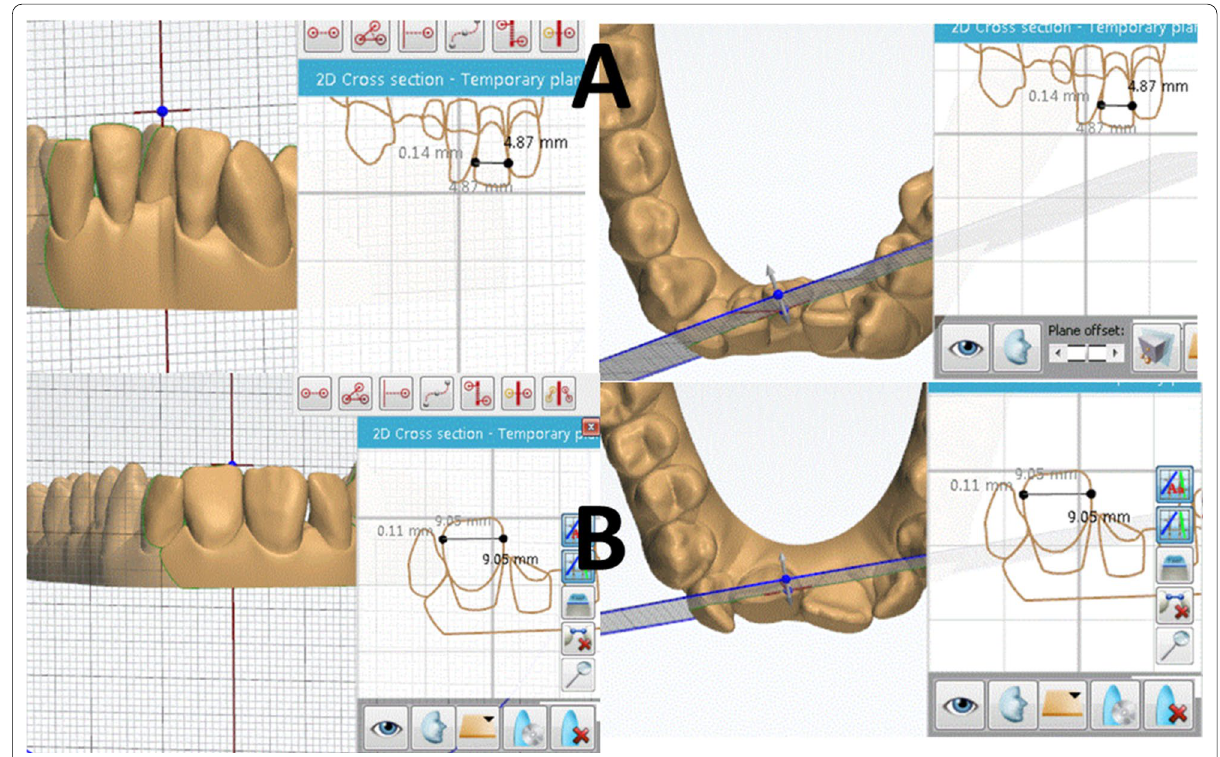
Fig. 2 Example for a 2D cross‑sectional measurement for mandibular ( A ) and maxillary incisors ( B